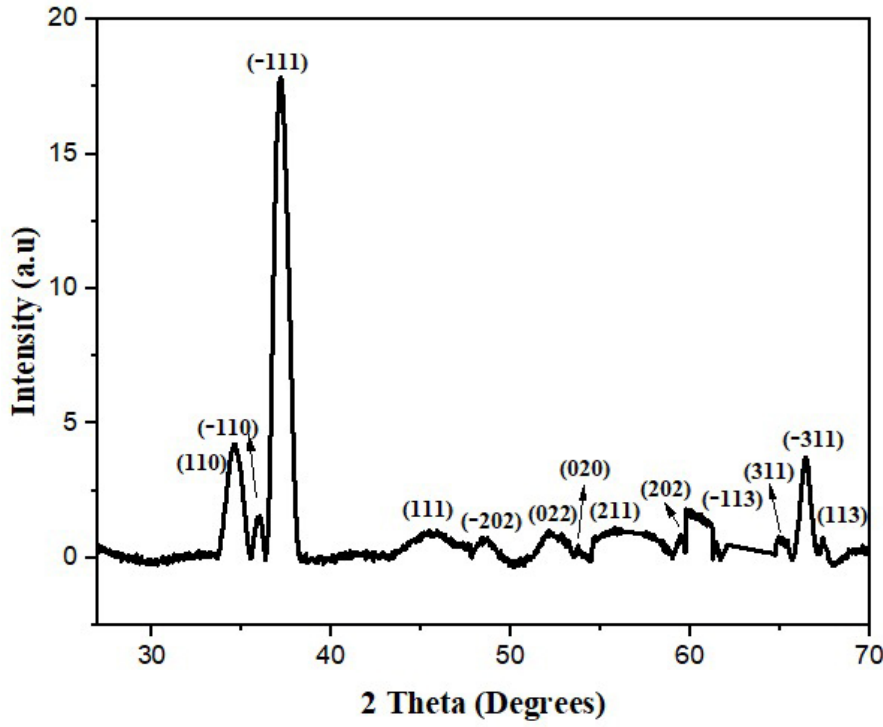
Figure 1. XRD diffractogram of biogenic CuO NPs (monoclinic CuO phase structure).